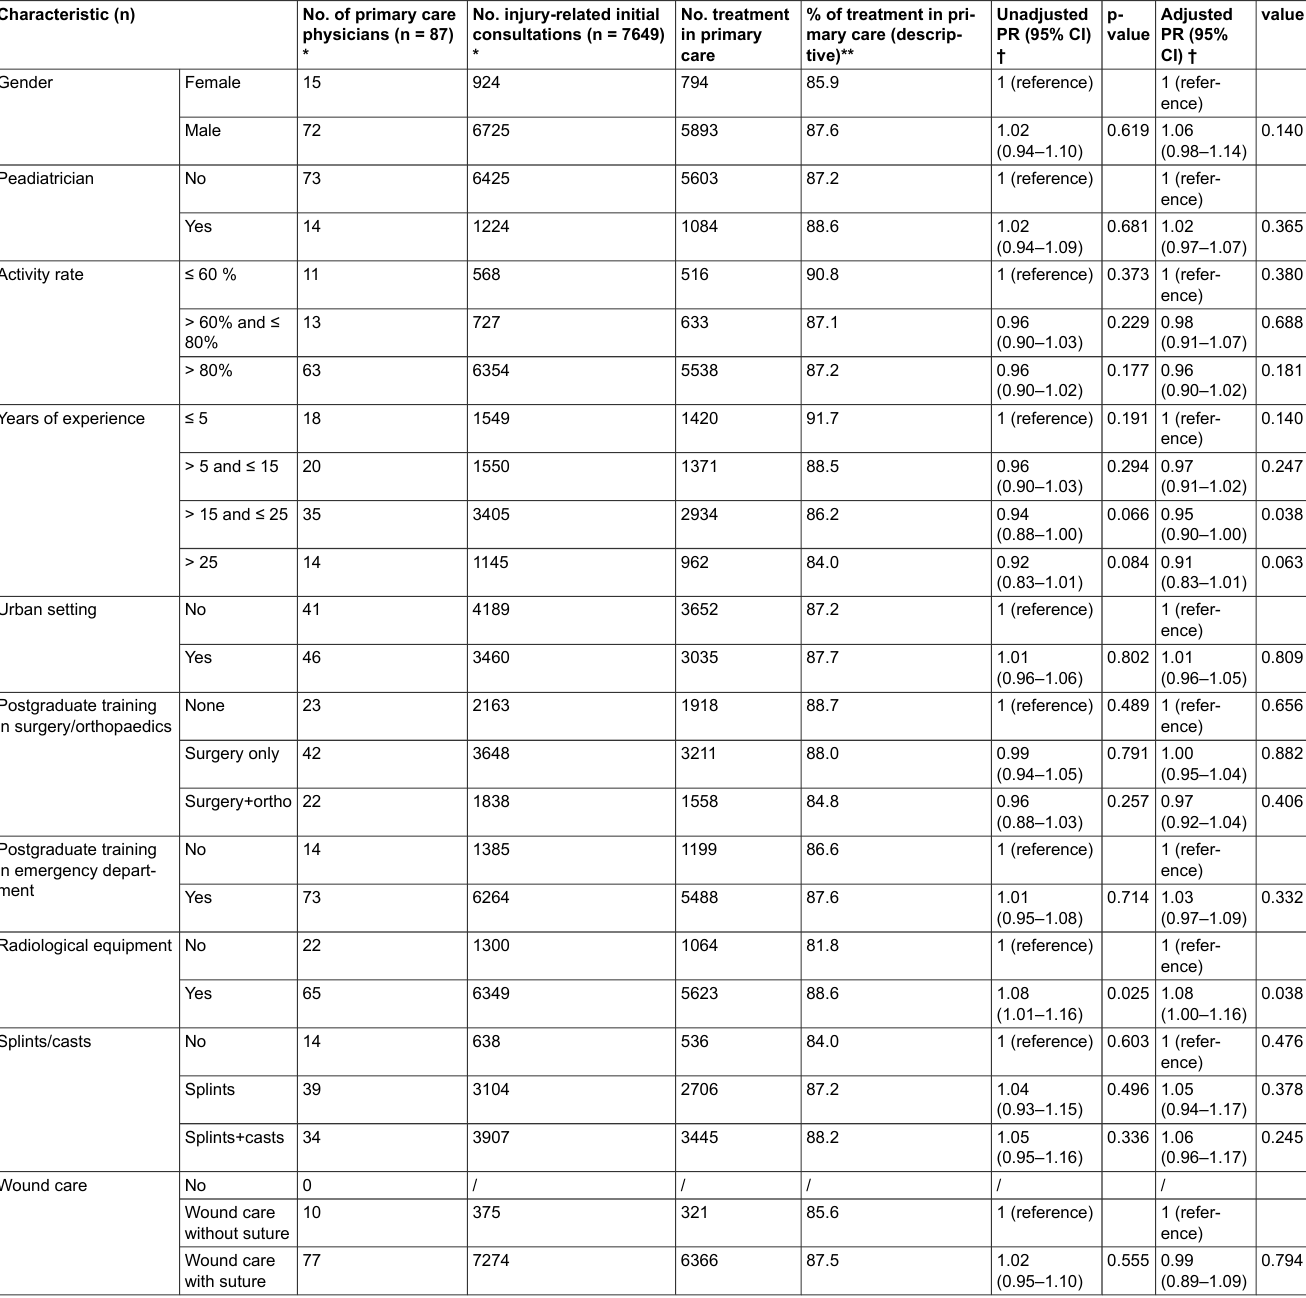
Table 5: Multivariable negative binomial regression analysis of the association between different practice characteristics and prevalence of independent management of patients at the primary care physician’s practice without secondary referral, at first consultation. Characteristic